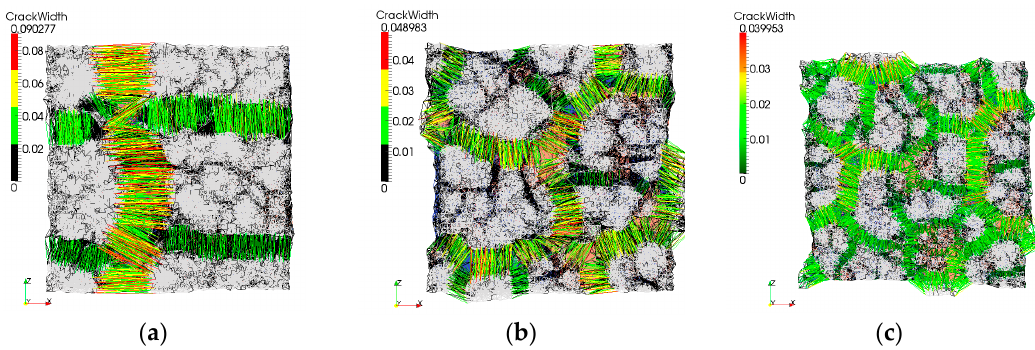
Figure 9. Damage development as a function of time, rough substrate surface, from top to bottom, at 5000, 10,000, 20,000 damaged elements, final crack widths at 110 days of drying ( a ) interface strength 1 MPa and 10 mm thick repair material; ( b ) interface strength 1 MPa and 6 mm repair material thickness and ( c ) interface strength 3 MPa and 6 mm thick repair mortar.